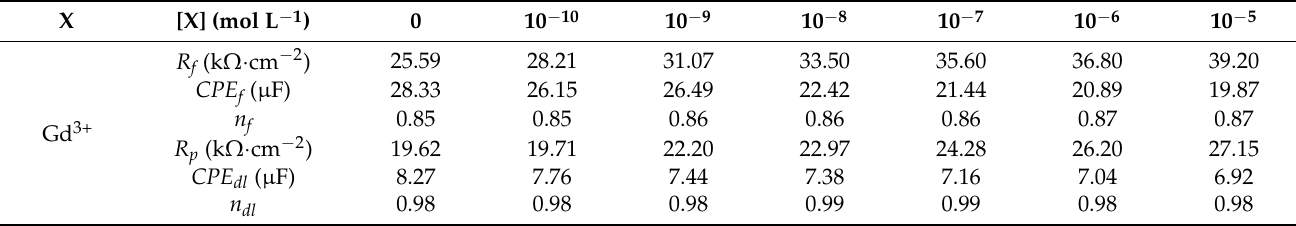
Table 2. Parameters of the electrical circuit equivalent to the Au/bis-N-MPyC electrode for different concentrations of lanthanides Gd 3+ , Eu 3+ , Tb 3+ and Dy 3+ . The active area was 0.19 cm 2 .